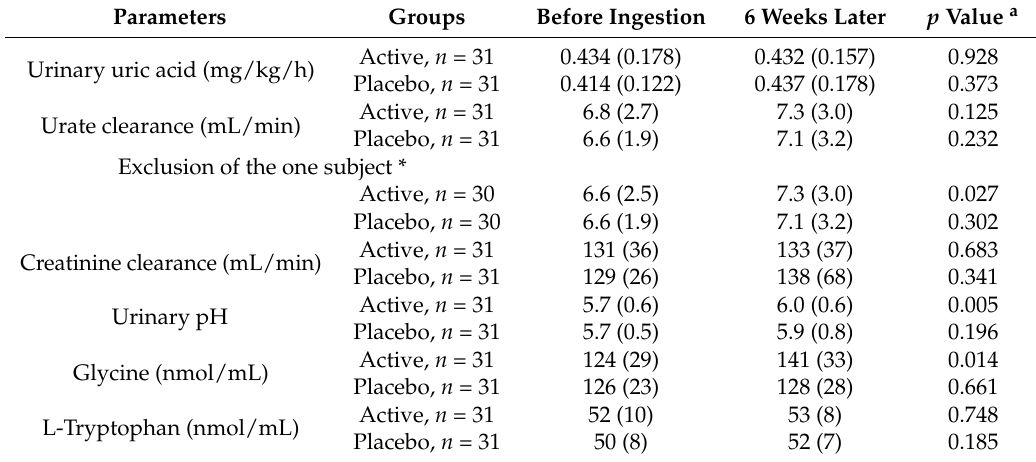
Table 4. Changes in urine parameters and serum amino acid levels in active and placebo